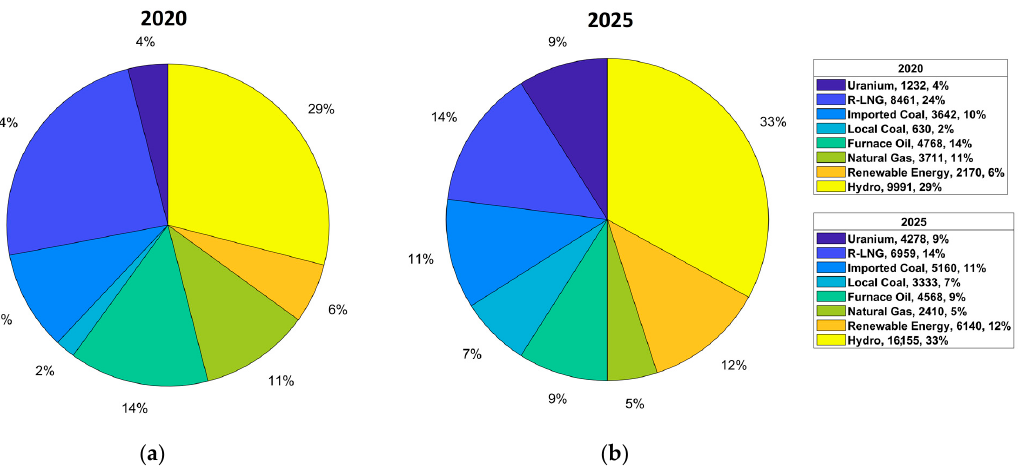
Figure 1. Energy mix of Pakistan (MW) ( a ) in the year 2020 and ( b ) the expected mix in the year 2025.